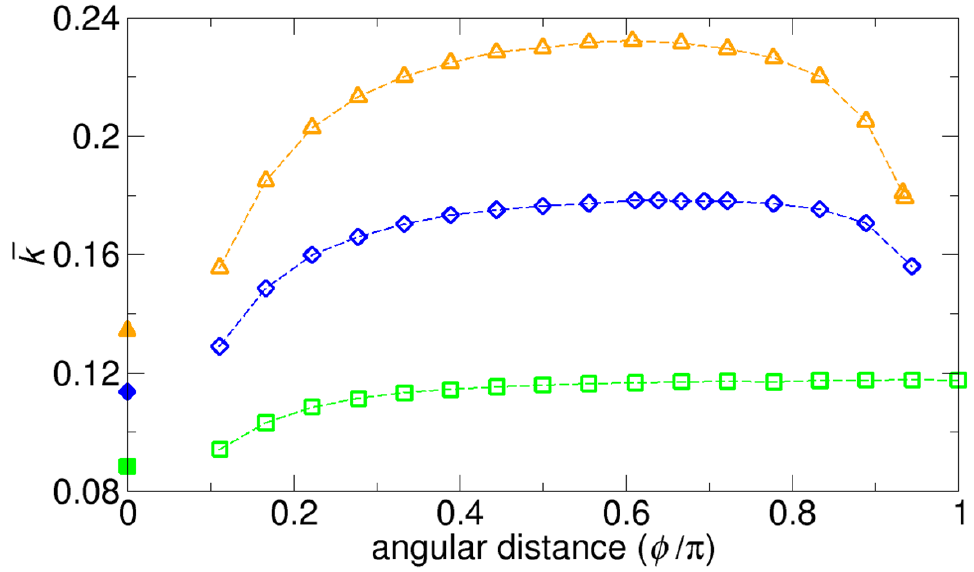
Figure 4. Rate constants k normalized by the Smoluchowski rate constant k SM for the systems in Figure 3 with two (green square), three (blue diamond), and four (orange triangle) reactive patches on a sphere. Note that the di ff erences between Figure 3 and this figure comes from di ff erent normalizations. The values at φ = 0 ◦ correspond to the rate constants calculated when the patches are merged into single patches that have the same total reactive area as the patches before merging.